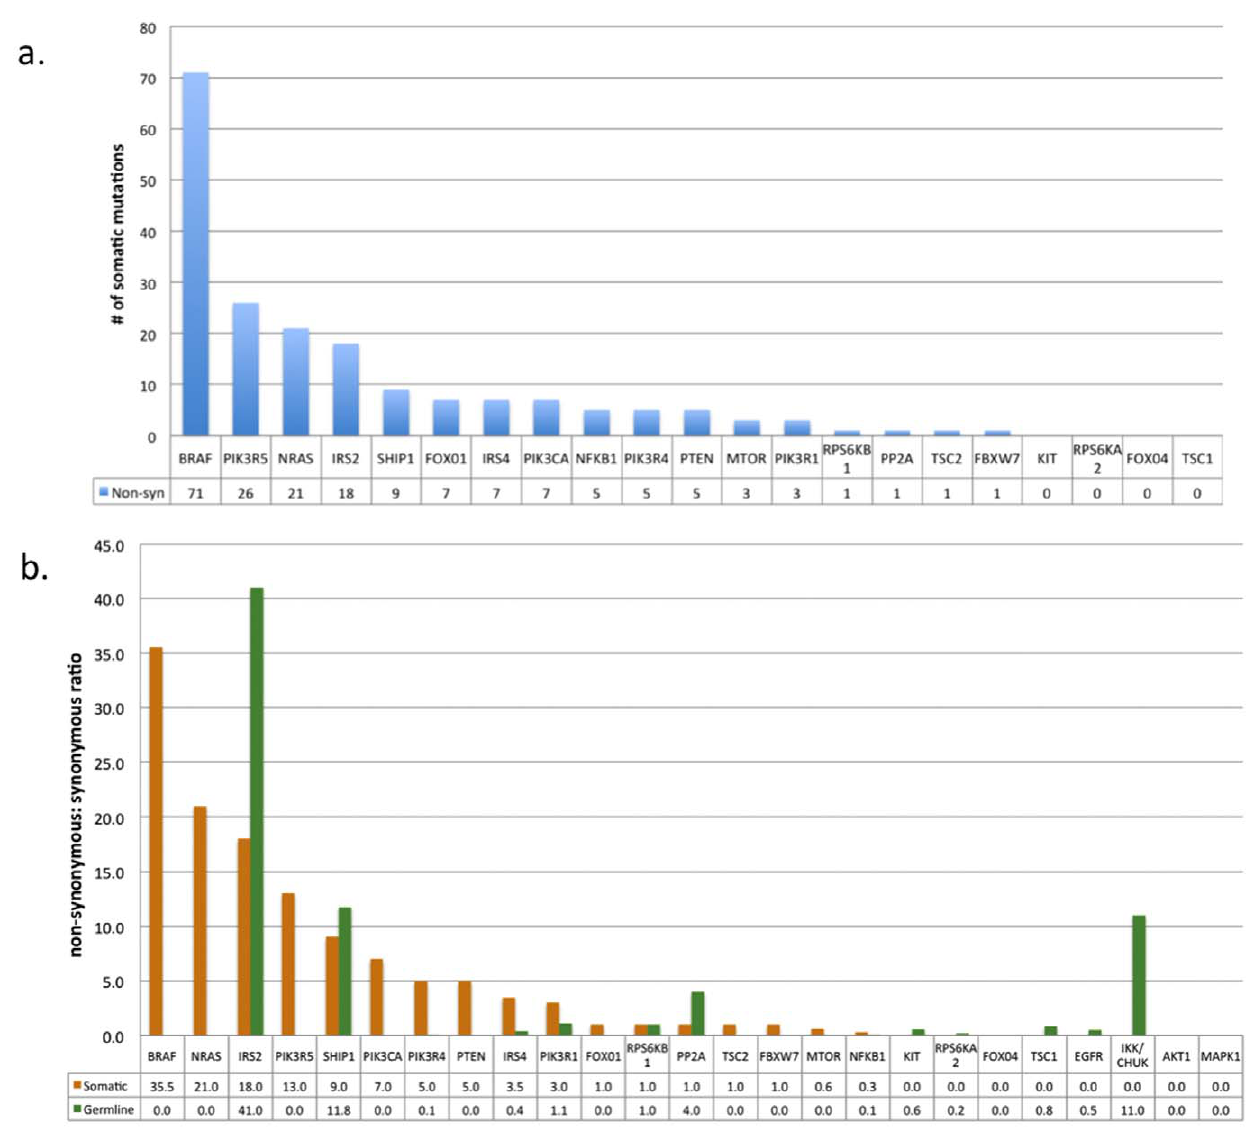
Figure 2. Counts and ratios of variants discovered in each sequenced gene. The absolute number of non-synonymous somatic variants for each gene is shown in (a) and the comparison of NS/S ratios for the germline and somatic variants of each gene is shown in (b). Blue shaded bars in (a) are non-synonymous mutations. The orange shaded bars are the NS/S ratios for the somatics variants, and the green shaded bars are the NS/S ratios for the germline variants.